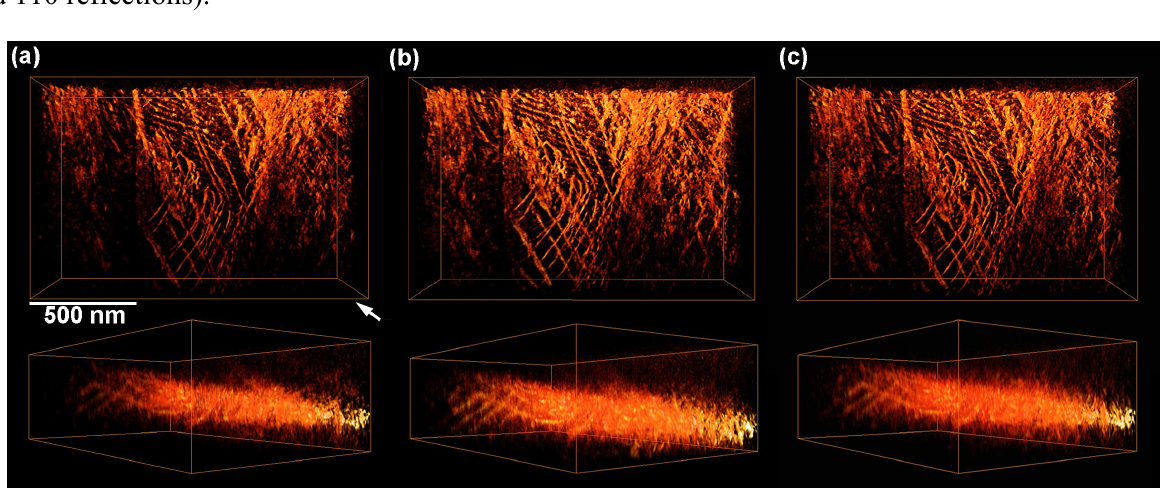
Figure 7. Effects of low contrast images and the maximum tilt angles on shapes and width of reconstructed dislocations. The maximum tilt angles and the number of images used for the reconstruction are as follows: ( a ) 70°, 63 images, ( b ) 70°, 71 images, ( c ) 40°, 41 images. An arrow indicates the viewing direction of the attached cross section